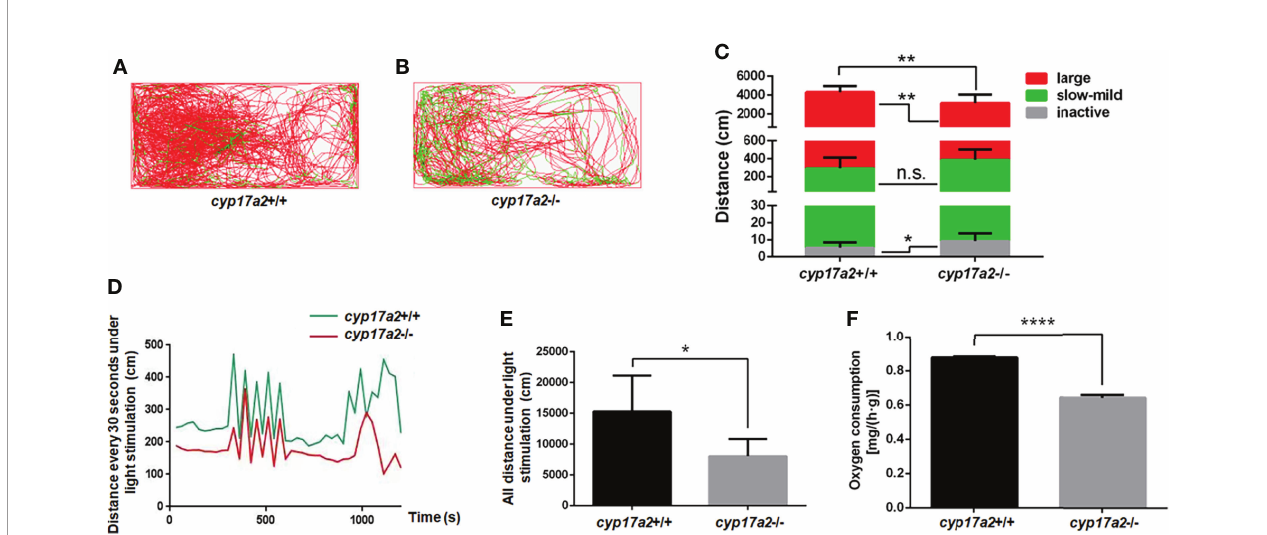
FIGURE 4 | cyp17a2 -de fi ciency resulted in impaired locomotion activity and stress response to light in zebra fi sh. (A, B) The locomotor trajectories of cyp17a2 +/+ and cyp17a2 -/- adult fi sh within 5 minutes (n = 10). (C) The distance fi sh covered at large, slow-mild, and inactive speed. The locomotor trajectories and distance covered at large (> 5 cm/sec), slow-mild (2-5 cm/sec) and inactive (< 2 cm/sec) speed in panel A-C are highlighted in red, green, and grey, respectively. (D) The movement distance curve analyzed in every 30 seconds under the light-stimulated stress within 20 minutes (n = 5). (E) All distance under the light-stimulated stress within 20 minutes (n = 5). (F) The oxygen consumption of cyp17a2 +/+ and cyp17a2 -/- fi sh after 2 days starvation (n = 3/group, 3 groups per genotype). n.s., no signi fi cant difference. * P < 0.05. ** P < 0.01. **** P <